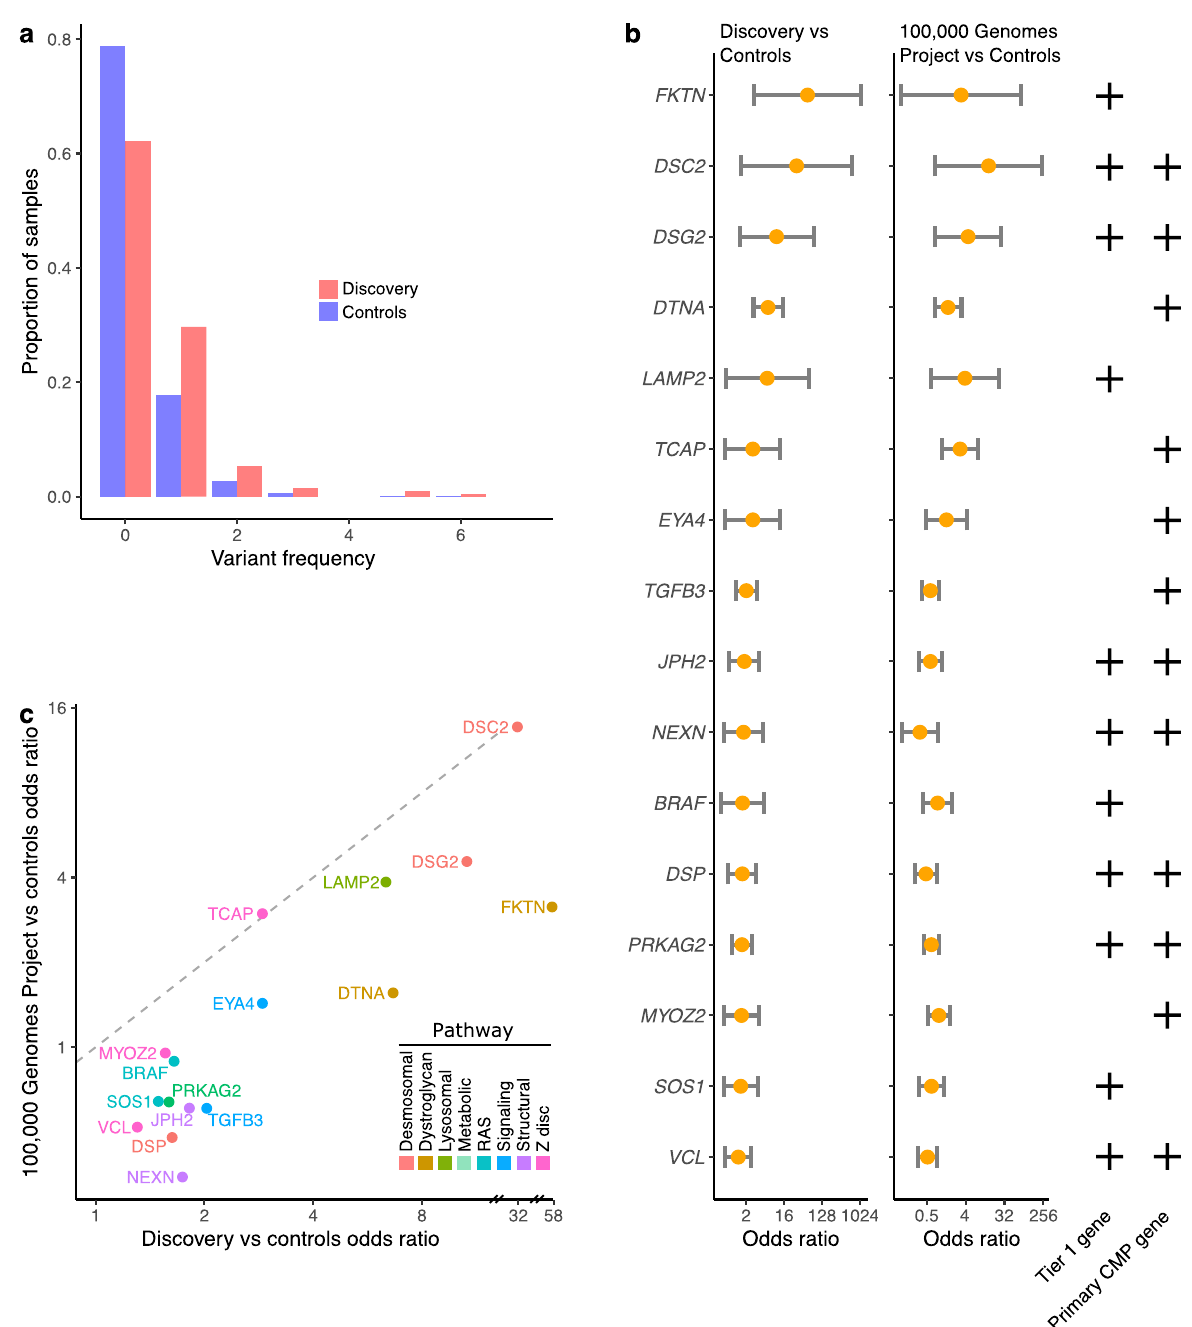
Fig. 3 Regulatory variant burden in cases ( n = 209) and controls ( n = 1326). a There was a signi fi cant enrichment of high-risk regulatory variants in CMP genes in the cases (orange) compared to controls (blue) (OR 2.25, 95% CI: 1.65 – 3.07, p = 6.70 × 10 − 7 ). b Burden of regulatory variants genes in cases in the discovery and 100,000 Genomes Project cohorts versus controls. Top 4 genes enriched for regulatory variants compared to controls included FKTN (OR = 58.1, CI: 3.1 – 1083), DTNA (OR = 6.7, CI: 3.0 – 14.8), DSC2 (OR = 32.0, CI: 1.5 – 668) and DSG2 (OR = 10.6, CI: 1.4 – 81). Tier 1 gene and primary CMP gene classi fi cations are denoted by plus symbols. c Replication cohort ( n = 1266): scatter plot showed a positive correlation between genes enriched for high-risk regulatory variants in the CMP discovery cohort vs the 100,000 Genomes Project replication cohort (Spearman ρ 2 0.555, p = 0.000936) with the top genes being similar in both CMP cohorts ( FKTN , DTNA , DSC2 , DSG2